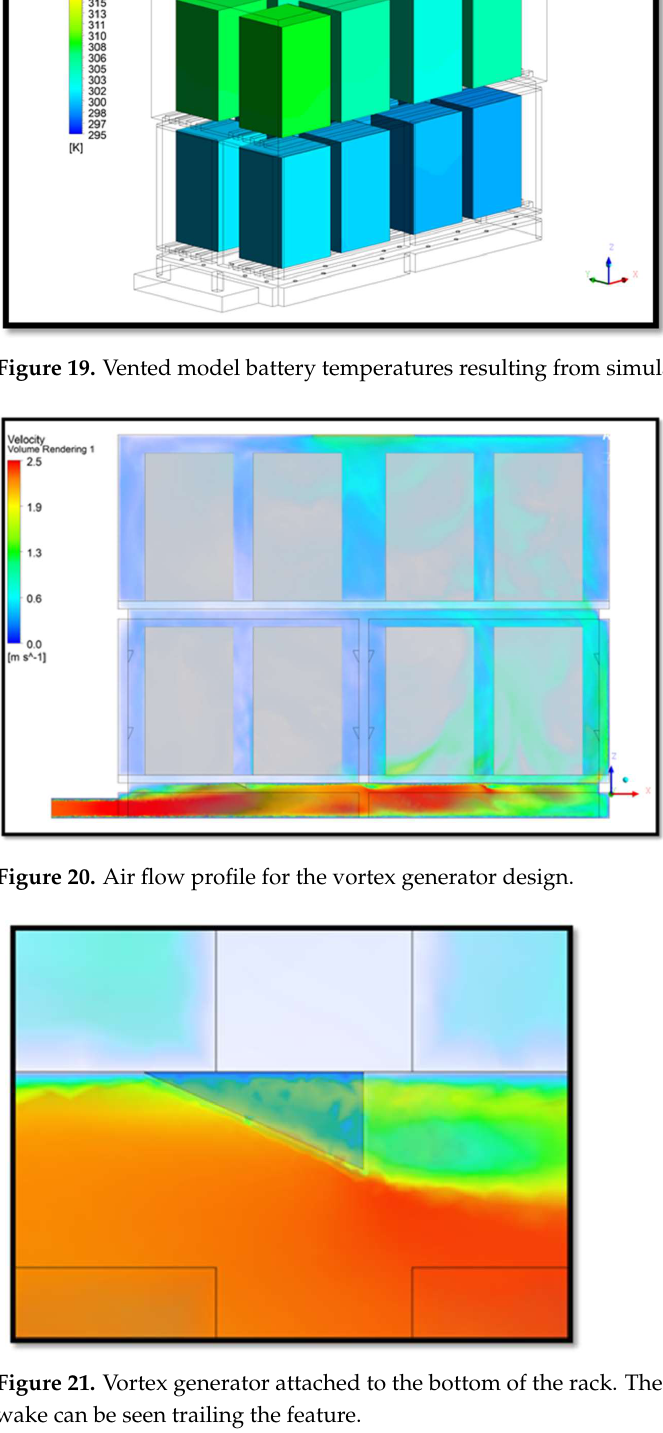
Figure 21. Vortex generator attached to the bottom of the rack. The boundary layer disruption and wake can be seen trailing the feature.